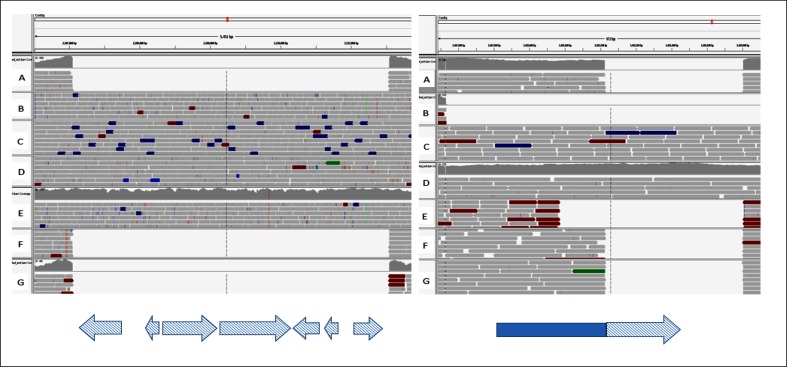
Integrative Genomic Viewer (IGV) of Illumina reads from different M. tuberculosis lineages (A, M. tuberculosis H37Rv; B, Indo-Oceanic; C, ancient Beijing; D, modern Beijing; E, East African Indian; F and G, Euro American) mapped on the ONT assembled genome highlighting the large insertions within the assembled genome. On the left: 4490 bp insertion (2 207 042–2 211 532) spanning seven annotated genes (blue checked arrows, NADH-dependent oxidoreducatse, iron-regulated elongation factor-tu, PE family protein and hypothetical/uncharacterized proteins). On the right: 390 bp insertion relative to H37Rv (3 488 211–3 488 601) spanning 323 bp (checked) at the end of a 654 bp coding sequence. ONT, Oxford Nanopore Technologies.